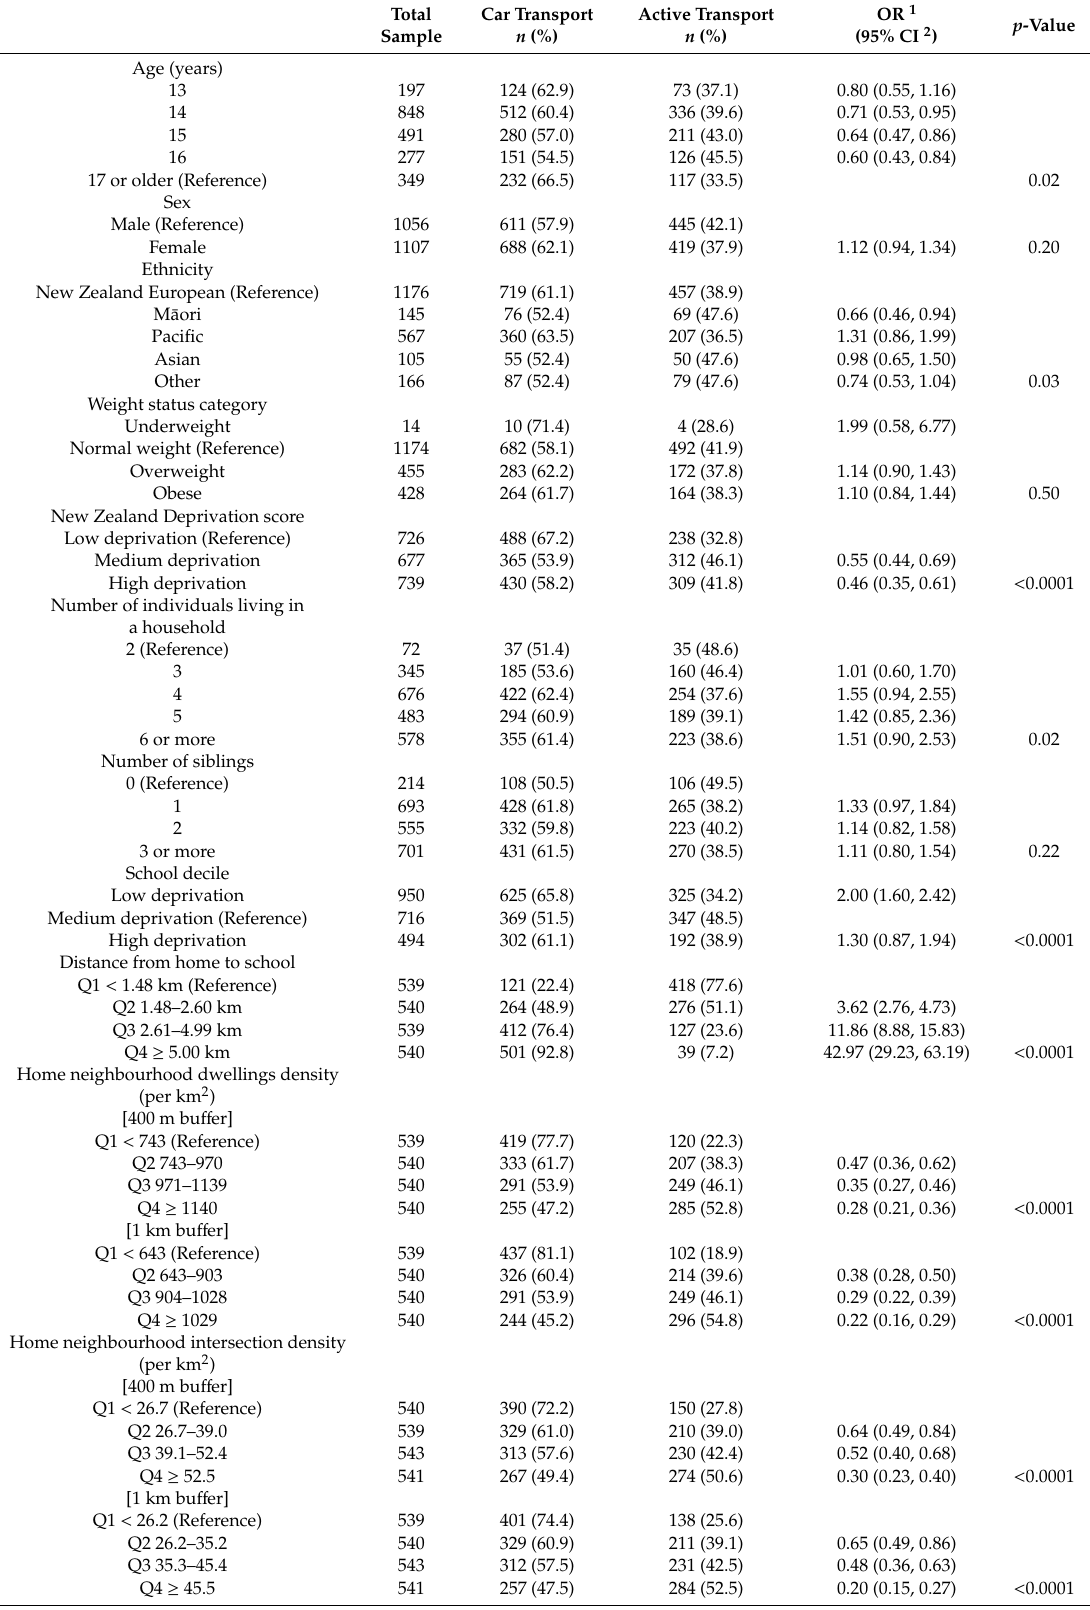
Table 1. Bivariate correlates of travelling to school by